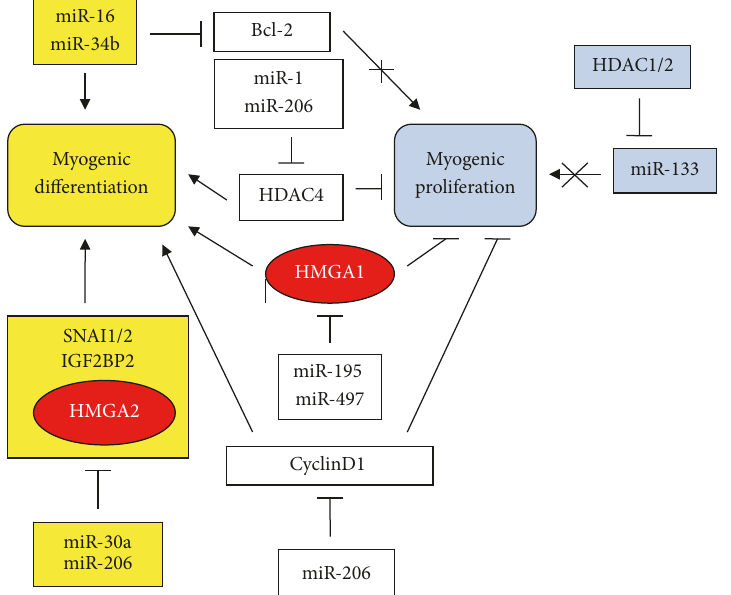
Figure 6: miRs, HDACs, and HMGA proteins in myogenic differentiation. Left side (yellow): induction of differentiation; right side (blue): suppression of proliferation. Symbols are the same as shown in Figure